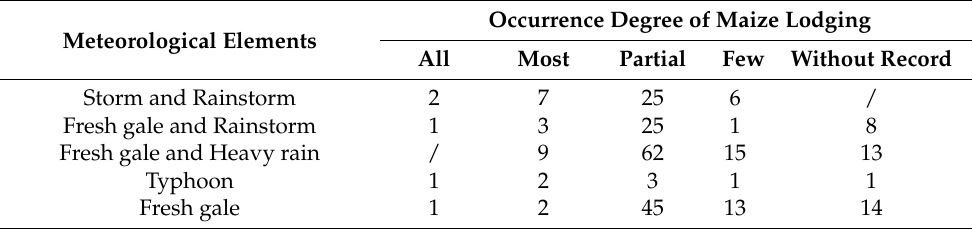
Table 4. The corresponding relationship between maize lodging and meteorological elements (Unit: time). Occurrence Degree of Maize Lodging Meteorological Elements All Most